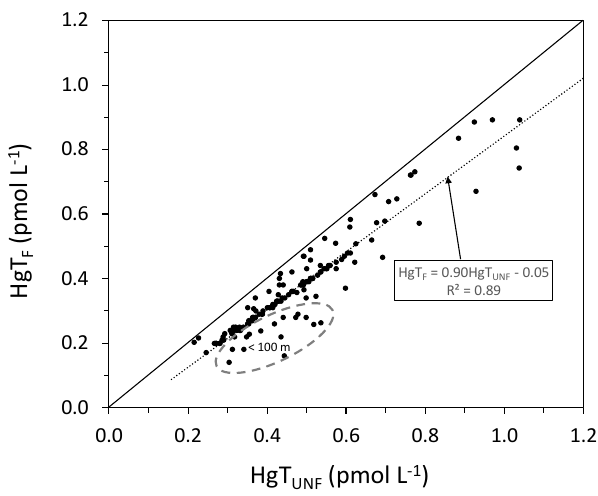
Figure 3. Mercury concentrations in filtered (HgT F ) vs. unfiltered (HgT UNF ) samples ( n = 141) collected along the G EOTRACES - GA01 transect.